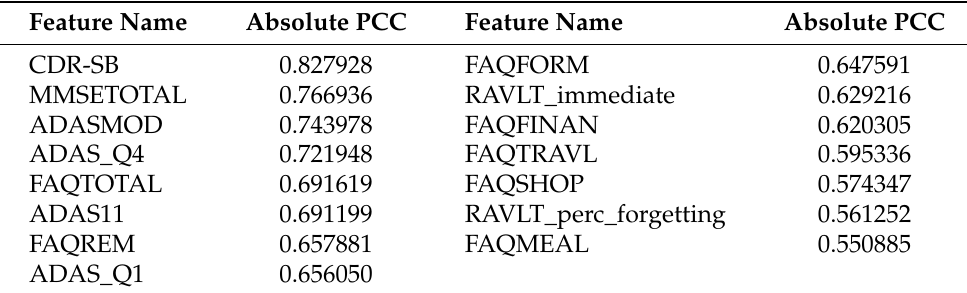
Table 2. The 15 items with the highest absolute